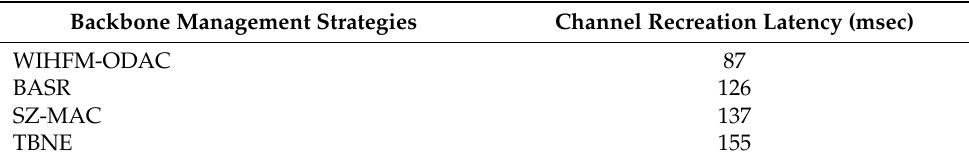
Table 4. Dynamic Channel Recreation